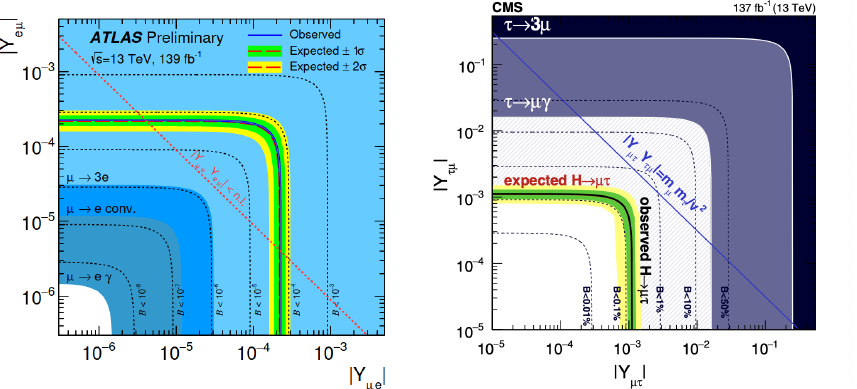
Figure 8. Left figure from [68]: constraint on LFV Yukawa couplings Y µ e , Y e µ from the limits on Br ( h → e µ ) (observed limit corresponds to the solid blue line, while the expected one is the dashed red line). Shaded regions show the sensitivity of µ → 3 e , µ → e γ and µ → e conversion on the LFV Yukawas, from the calculations of [75]. Right figure from [69]: same plot for the τ ↔ µ sector. The diagonal line shows the natural limit